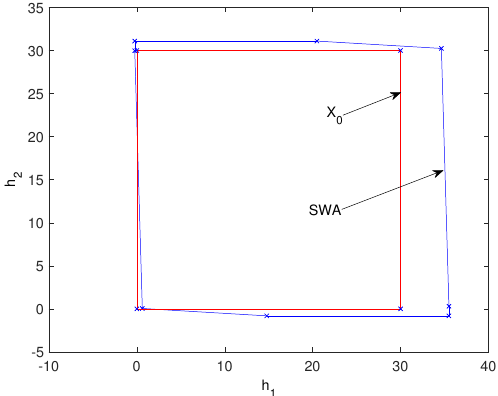
Figure 4. Initial zonotope ( X 0 ) and SWA of two-tank system.